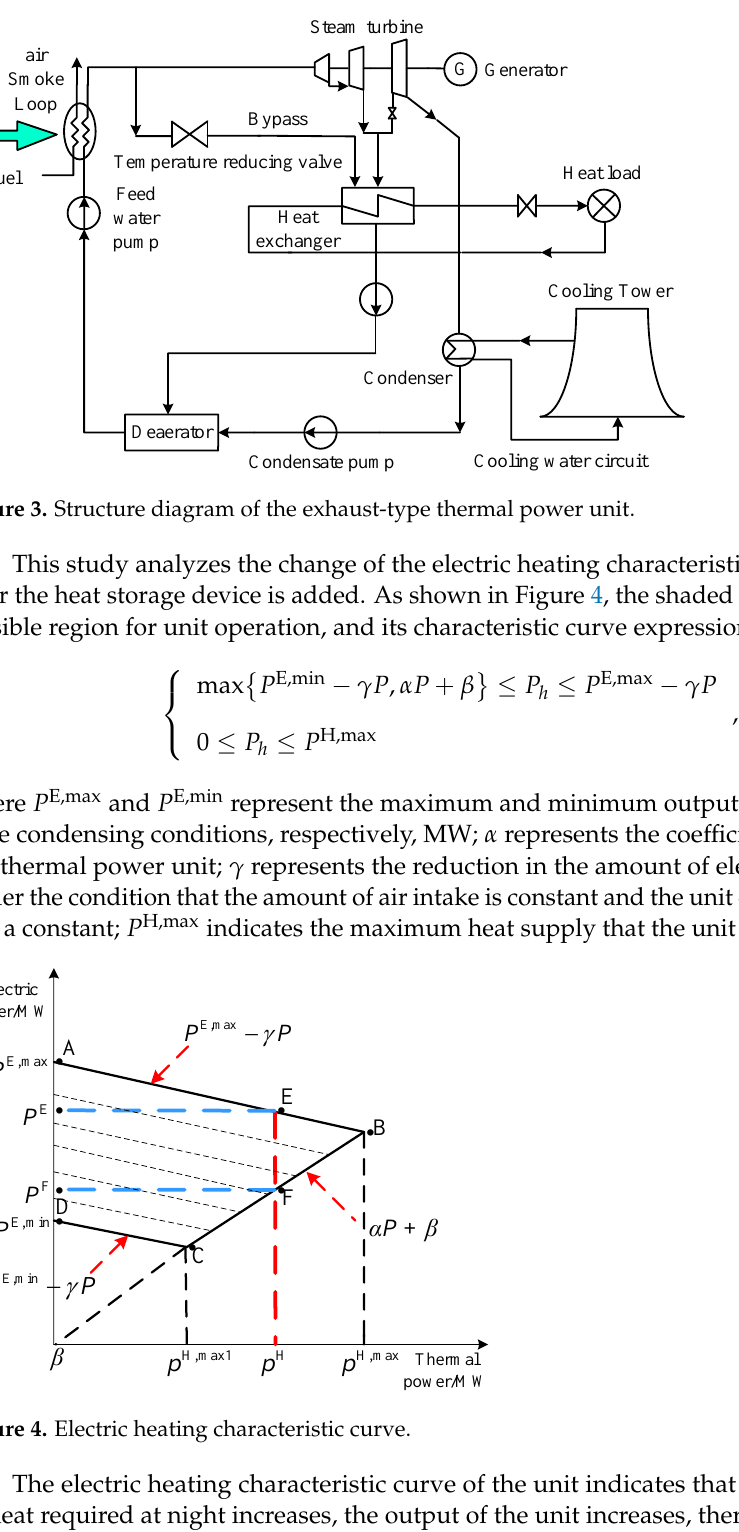
Figure 4. Electric heating characteristic curve. The electric heating characteristic curve of the unit indicates that when the amount of heat required at night increases, the output of the unit increases, thereby increasing the forced electric output and reducing the peak regulation capacity of the unit. When the heating power of the unit is P H , the adjustment range of the electric power is P E − P F and the peak regulation capacity is